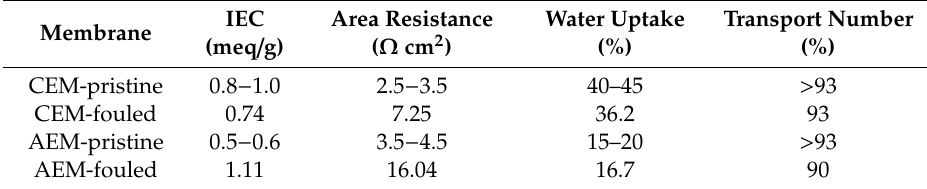
Table 2. The main properties of the pristine and fouled